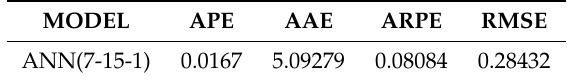
Table 9. Prediction error by ANN(7-5-1)